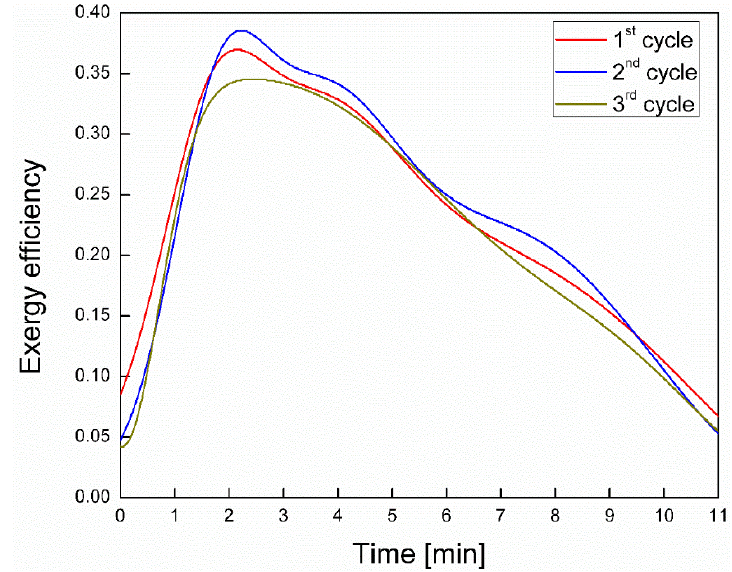
Figure 11. Variation of the exergy efficiency of the adsorption chiller.